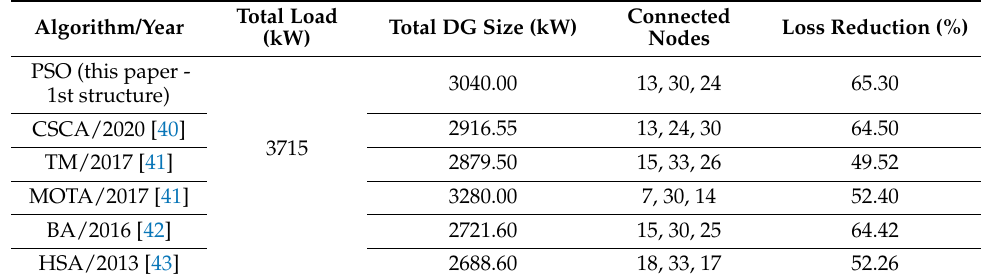
Table 3. Comparison of loss reductions of different algorithms in IEEE 33 bus system with three DGs.